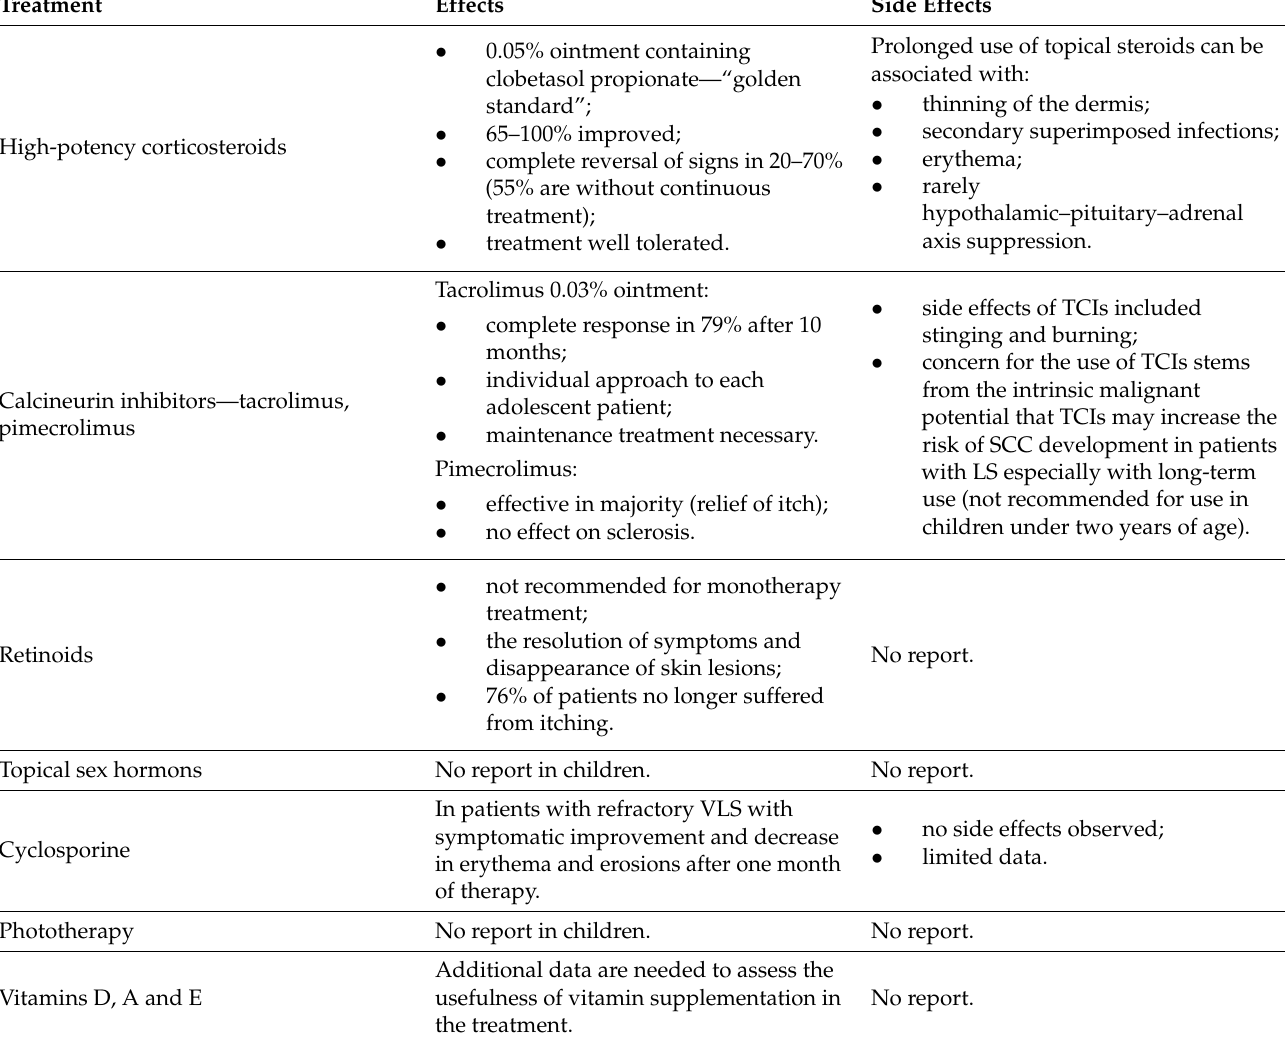
Table 1. Management for pediatric vulvar lichen